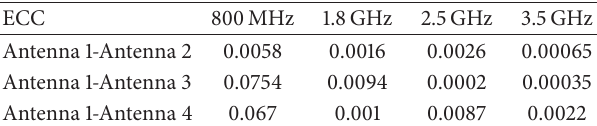
Table 2: Simulated ECC for the different antenna combinations.